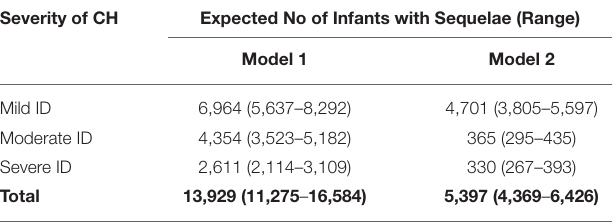
TABLE 3 | Severity of congenital hypothyroidism (CH)